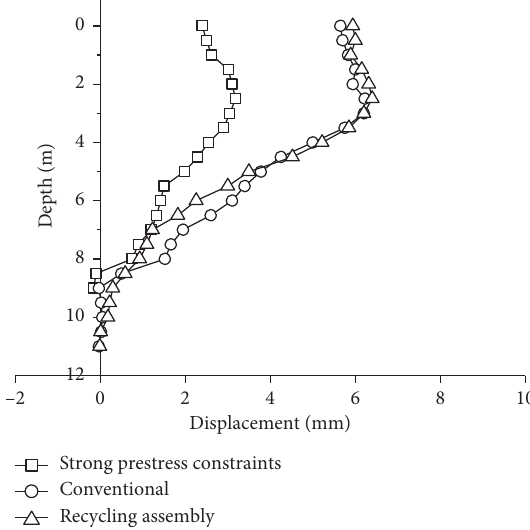
Figure 17: The comparison of horizontal displacement for three front row piles.